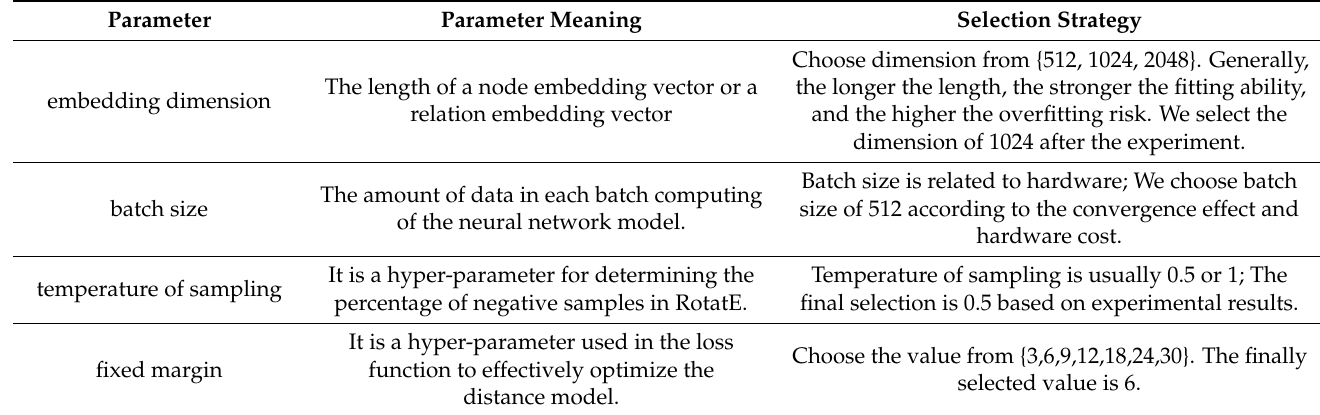
Table 5. Descriptions of the parameters and the selection